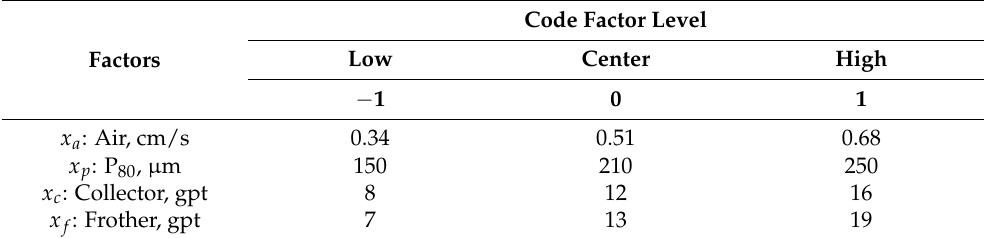
Table 6. Factors and their levels for BBD experiments used in Case 1 and Case 2. Code Factor Level Low Center Factors